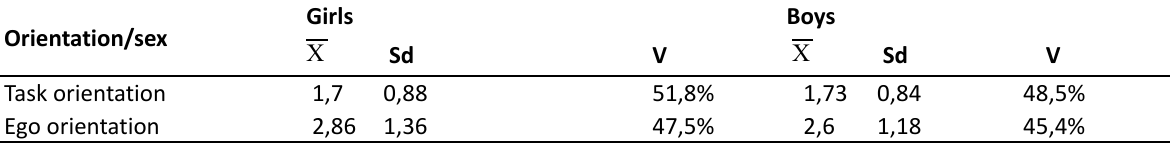
Table 5. Perceptions of success and sex